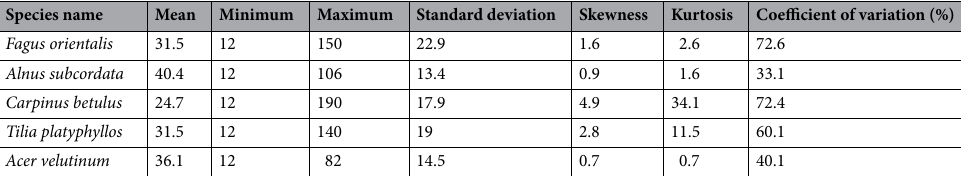
Table 2. Summary statistics describing species’ diameter at breast height